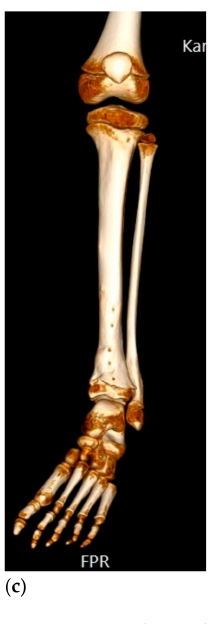
Figure 1. Biological reconstruction using the bone transport technique ( a ) A two-year old girl presented to the emergency department unable to walk on her left leg after a mild fall 3 days earlier. She also had a fever and a c-reactive protein count of 87 mg/liter. X-ray showing a lytic lesion located centrally in the distal tibial metaphysis of the left leg. There is a relatively narrow, but indistinct zone of transition. Periosteal reaction involving the medial aspect of the tibia was observed. Open biopsy showed a dense proliferation of small round blue cells in hematoxylin and eosin. Immunohistochemistry showed membranous positivity for the CD99 marker; staining was also positive for S-100 and periodic acid–Schiff (PAS). Fluorescent in situ hybridization (FISH) demonstrated an EWSR1-FLI1 fusion transcript consistent with the diagnosis of Ewing sarcoma. Staging procedures did not show any metastases. ( b ) Induction chemotherapy with VIDE (vincristine, ifosfamide, doxorubicin, and etoposide) was given according to the Euro-Ewing 2008 protocol. Thereafter, physeal distraction, tumor resection, and segmental bone transport with the use of the Taylor Spatial Frame were carried out. The external fixator was removed after 6 months. ( c ) Five years after removal of the external fixator, the girl is pain free and is able to run and walk without any limitations. Two deformity procedures have been performed after completing oncologic treatment due to a varus deformity secondary to a physeal arrest in the distal tibial physis. She has no evidence of